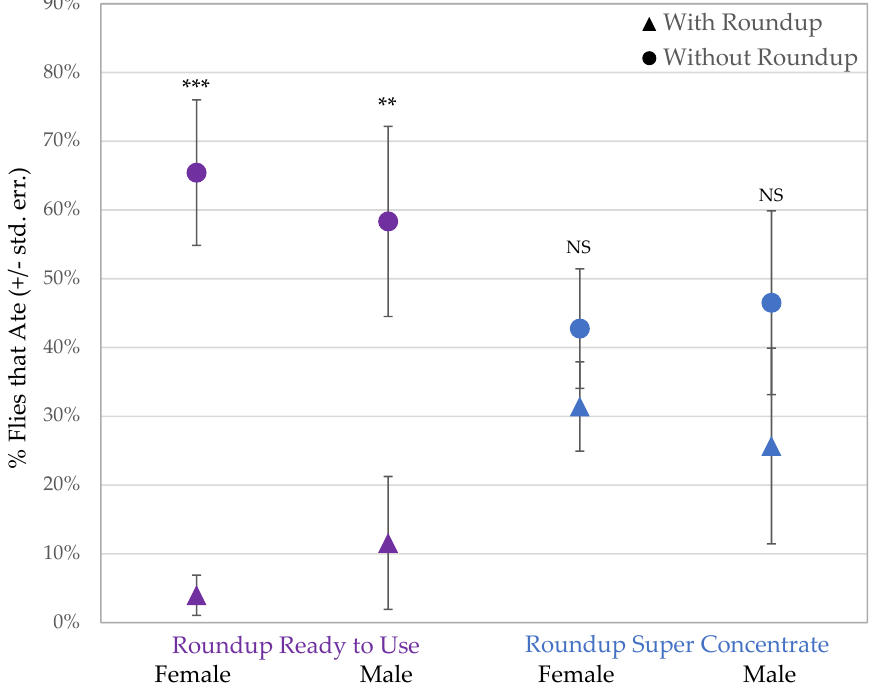
Figure 2. Female and male flies consumed significantly more organic sucrose in a 2-choice test when given the alternative option of sucrose with Roundup ® Ready to Use (purple/left; *** p < 0.001, ** p < 0.01). There was no difference in sucrose consumption during exposure to Roundup ® Super Concentrate sucrose or control sucrose (blue/right, NS p > 0.05).